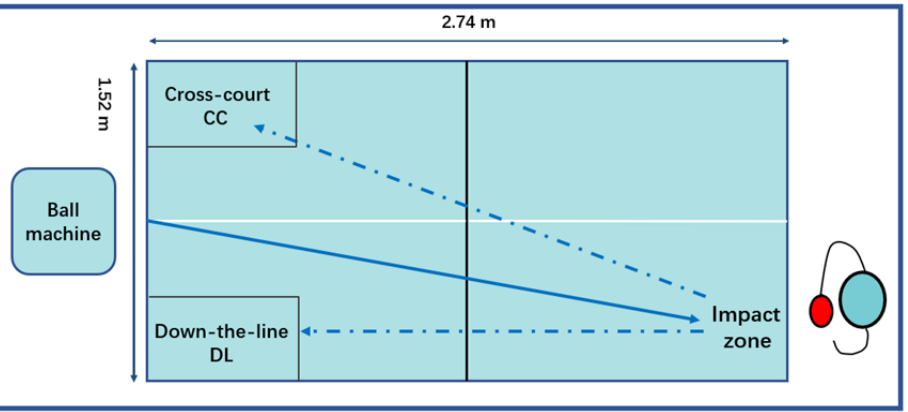
Figure 1. Experimental set-up of the study. CC = cross-court, DL = down-the-line. The solid line is the track of the ball projected by the machine, and the dash-dotted line is the track of the ball returned by the player.